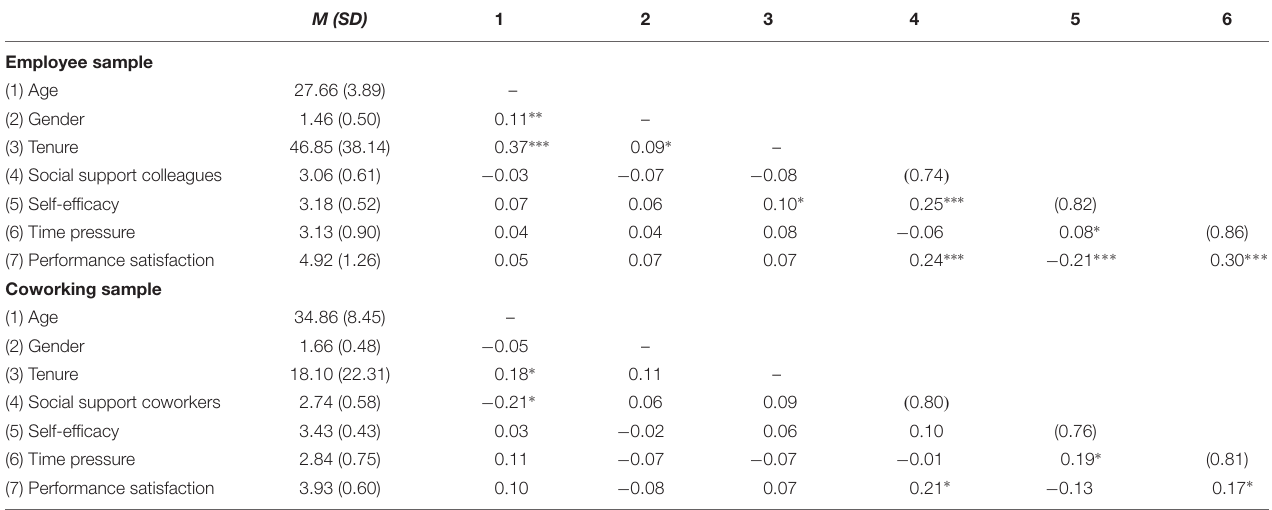
TABLE 2 | Means, standard deviations, reliabilities (cronbach’s alpha on the diagonal), and correlations between the study variables. M (SD) 1